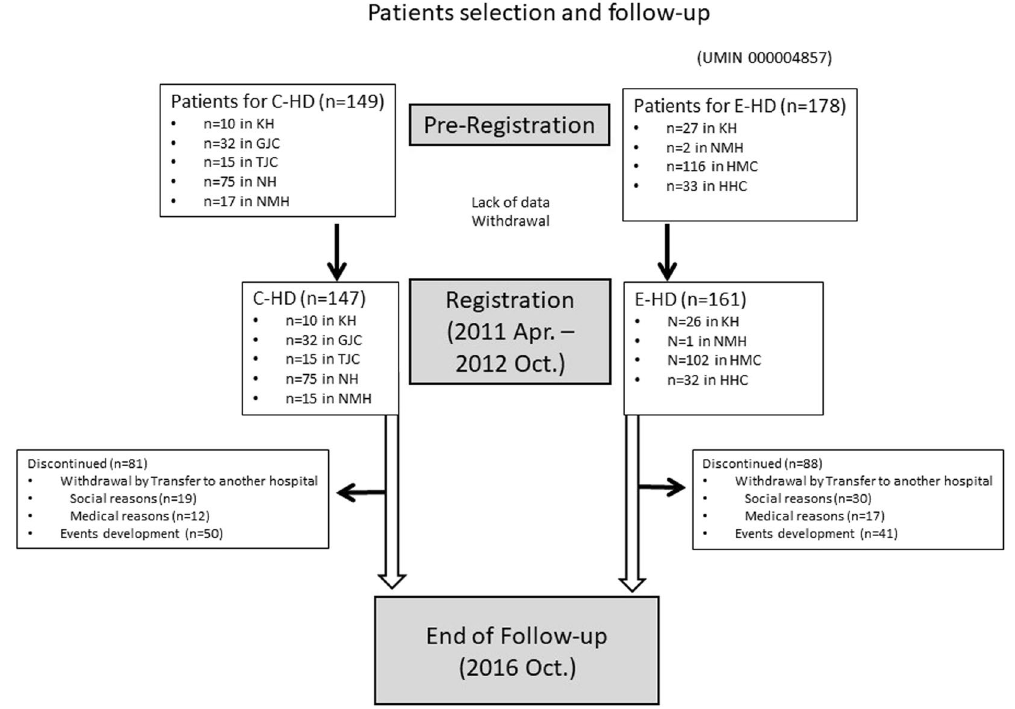
Figure 1. Flow chart from pre-registration to the end of observation. Abbreviations: C-HD, conventional haemodialysis; E-HD, electrolyzed water haemodialysis; KH, Kashima Hospital; GJC, Gumyoji Jin Clinic; TJC, Tateishi Jin Clinic; NH, Noboribetsu Hospital; NMH, Nikko Memorial Hospital; HMC, Higashi Muroran Clinic; HHC, Higashi Horai